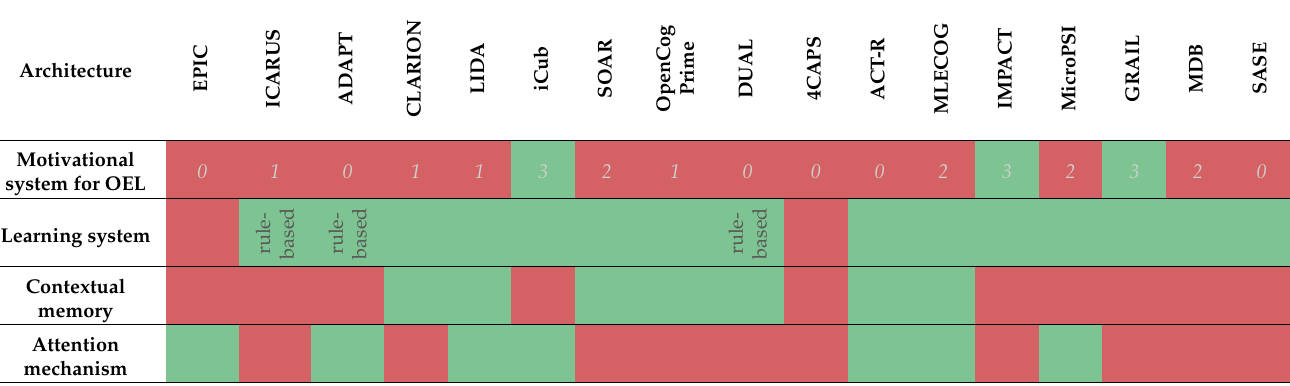
Table 2. Main components to achieve LOLA and cognitive architectures that implement